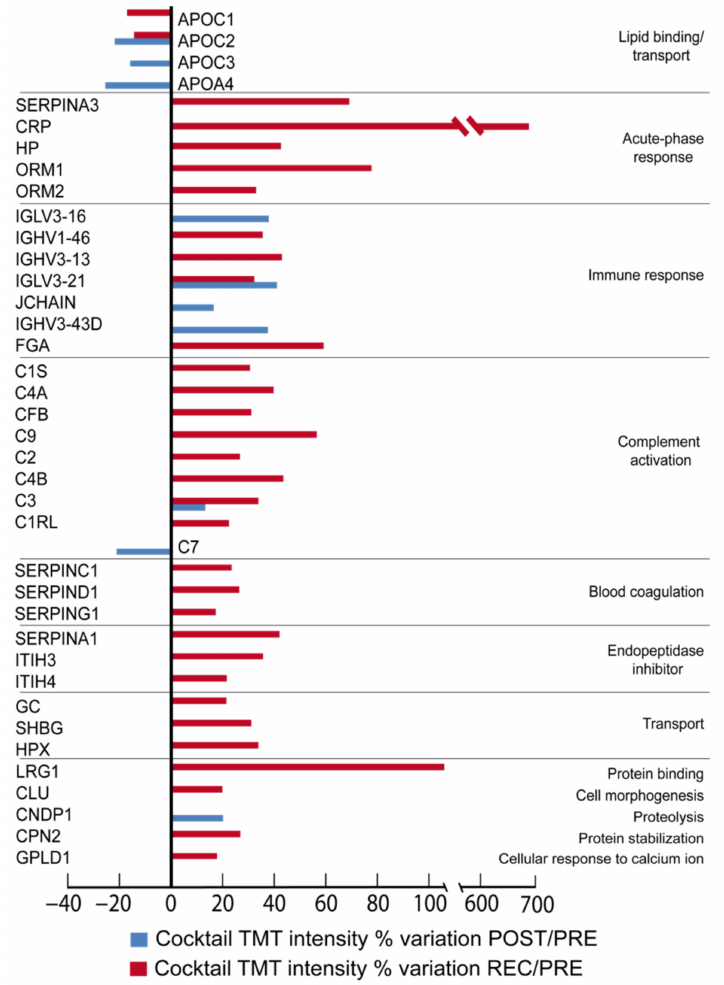
Figure 1. TMT LC-MS/MS proteomic analysis results from sera samples of cocktail-treated BR group. Differential abundant proteins are expressed as histograms representing their intensity as a percentage of variation from PRE. Blue bars represent variation identified in the POST/PRE, while red bars are alterations identified in the REC/PRE comparison. One-way repeated measures ANOVA and Tukey’s test, n = 5, p -value <